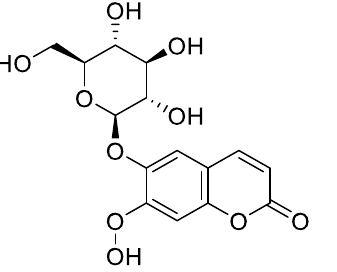
Figure 5. Chemical structure of aesculin (7-hydroxy-6- O -glucosylcoumarin).